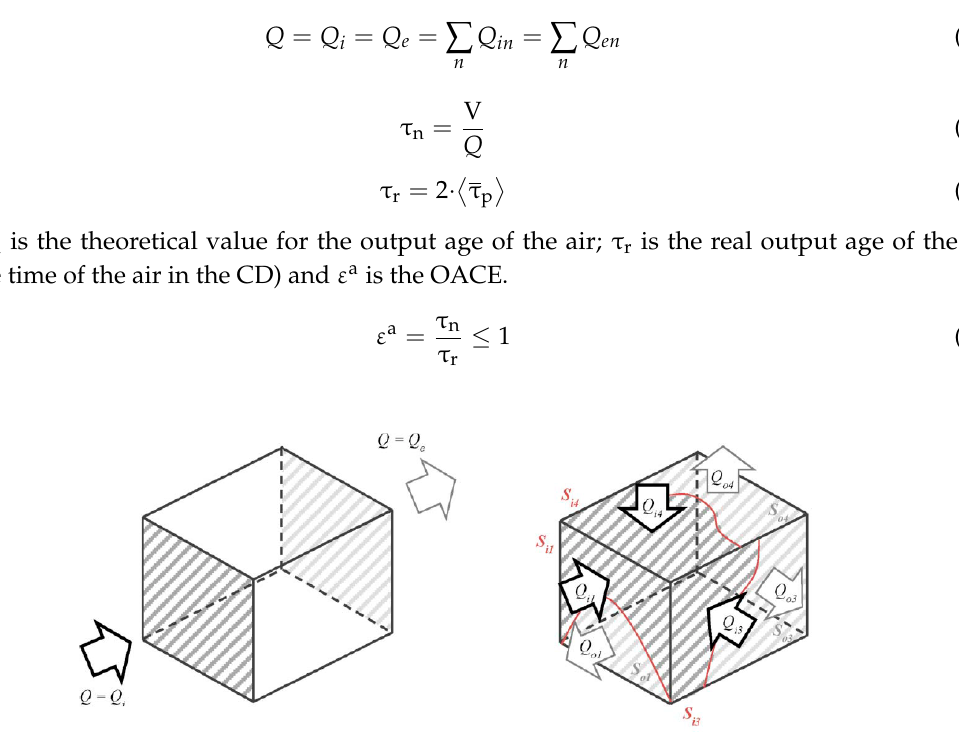
Figure 5. Air flow equilibrium in the control domain (CD) for a section of the wind tunnel and for an open environment.